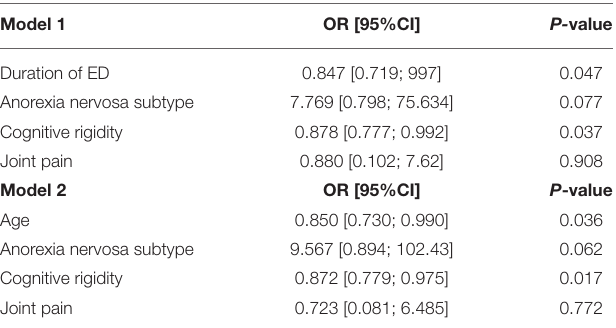
TABLE 2 | Multivariate regression logistic models with JHM status as dependent